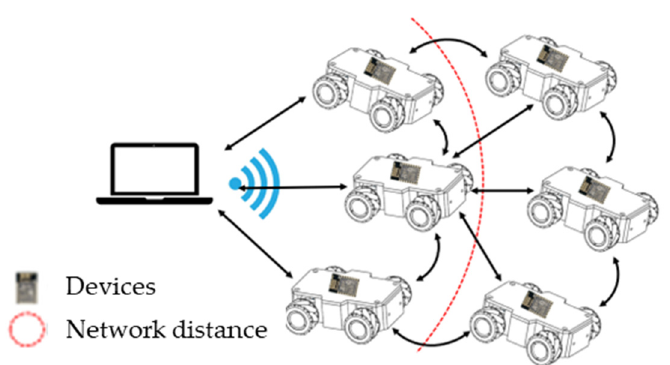
Figure 4. ESP-MESH of modular vehicles.